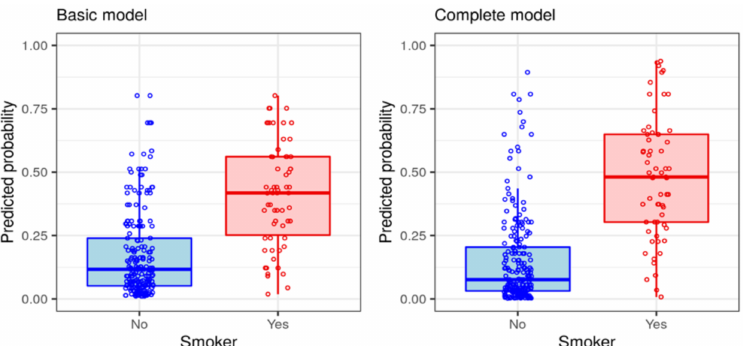
Figure 3. Predicted probabilities in smokers and nonsmokers, calculated by the ( left ) basic and ( right ) complete models. Boxplots show median probabilities (solid horizontal lines), interquartile ranges (boxes), and 95% confidence intervals for medians (whiskers). Individual values shown in open